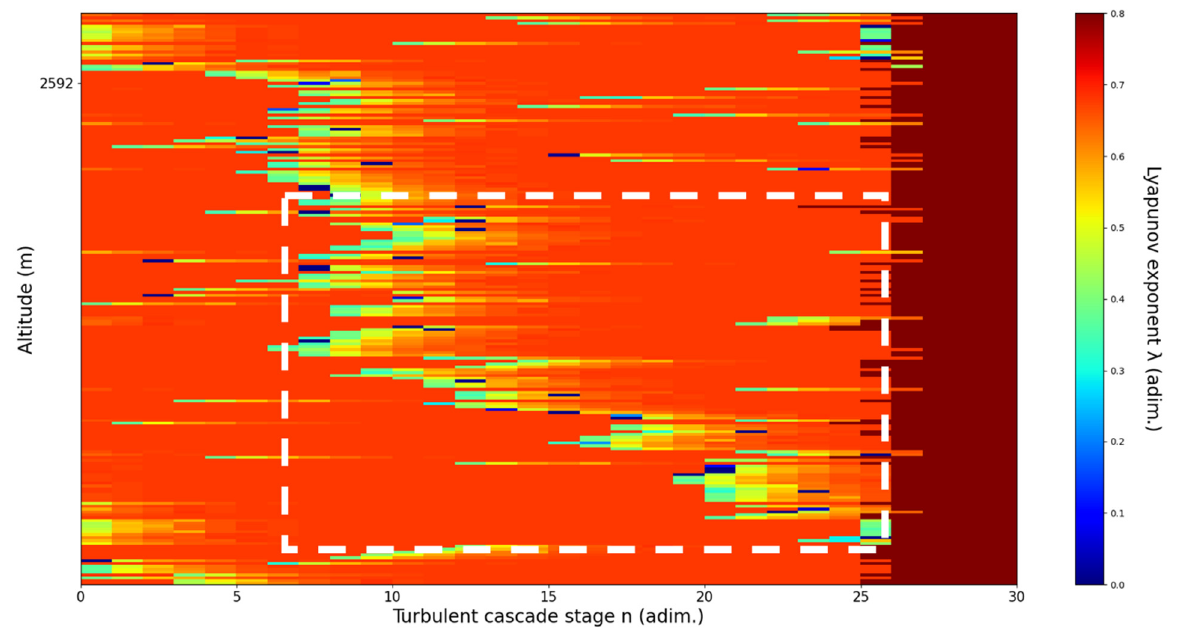
Figure 16. Lyapunov exponent per turbulent cascade stage colormap altitude plot, Bucharest, Romania, 13 June 2019,